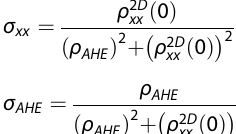
Fig. 3 RESPES and ARPES VB data. a Angle integrated ARPES VB data of SrTiO 3 , and EuTiO 3 q2DEG surface state, compared to angle and photon-energy integrated RESPES VB of (001) LAO(5 uc)/STO (containing oxygen vacancies) and LAO(5 uc)/ETO(2 uc)/STO hetero- structures. Multiple gaussian fi t of the LAO/ETO/STO VB pro fi le is used to determine the Eu 3 + /Eu 2 + ratio. The IGS in gap states is observed only in STO and LAO/STO q2DEGs due to the presence of oxygen vacancies. b (left panel) RESPES color-map of the valence band region and CIS spectra obtained integrating the RESPES data around BE = − 2 eV (Eu 2 + , black scatter data) and between − 7 and − 4 eV (O - 2p, cyan scatter data). The white line is the total electron yield XAS spectrum; (right panel) the same RESPES map in the Fermi level region and corresponding CIS spectrum (yellow scatter